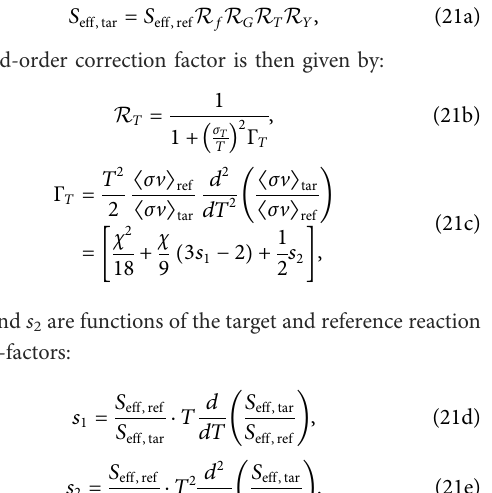
FIGURE 3 (A) Plot showing the temperature dependence of the second-order yield ratio temperature variance correction, Γ T . IncludingtheeffectoftheeffectiveS-factortemperatureisshown. (B) Plot showing the R T value for Gaussian distributions of burn-averaged temperatures, denoted N ( μ , σ ) where μ and σ are the mean and standard deviation, respectively. Numerical evaluations are shown as black lines. Green lines show the second-order expressions for R T using Γ T , while the blue lines set s s 1 = 2 =